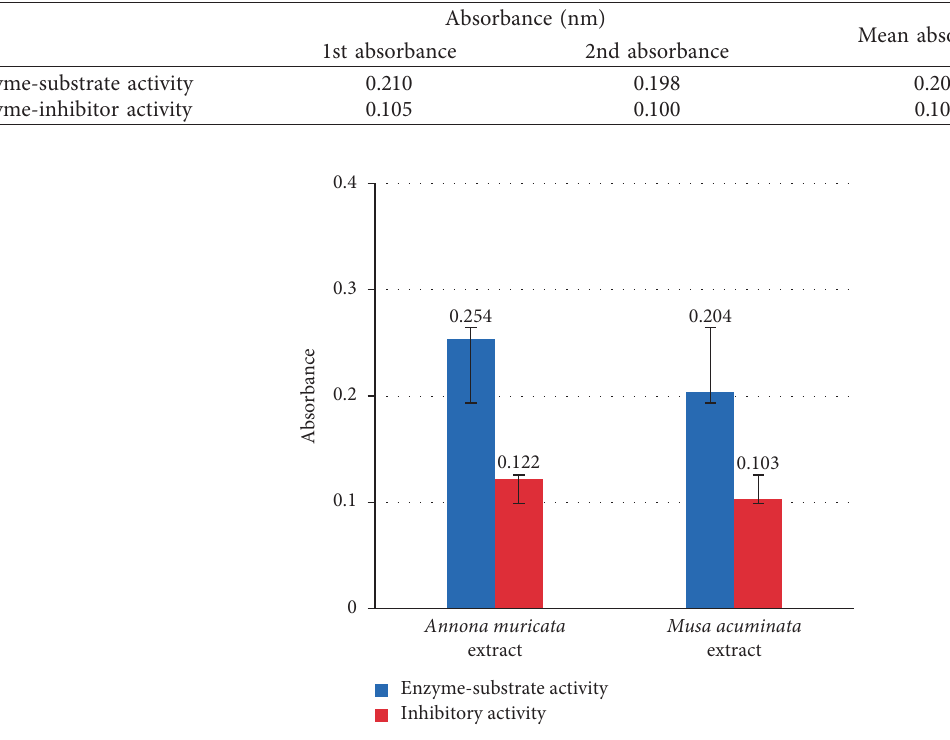
Figure 2: Enzymatic activities and variation of inhibitory activities with cinnamon bark oil.